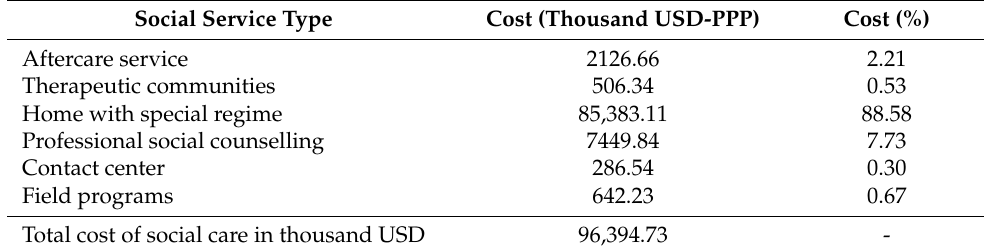
Table 14. Social services costs attributable to alcohol, 2017.